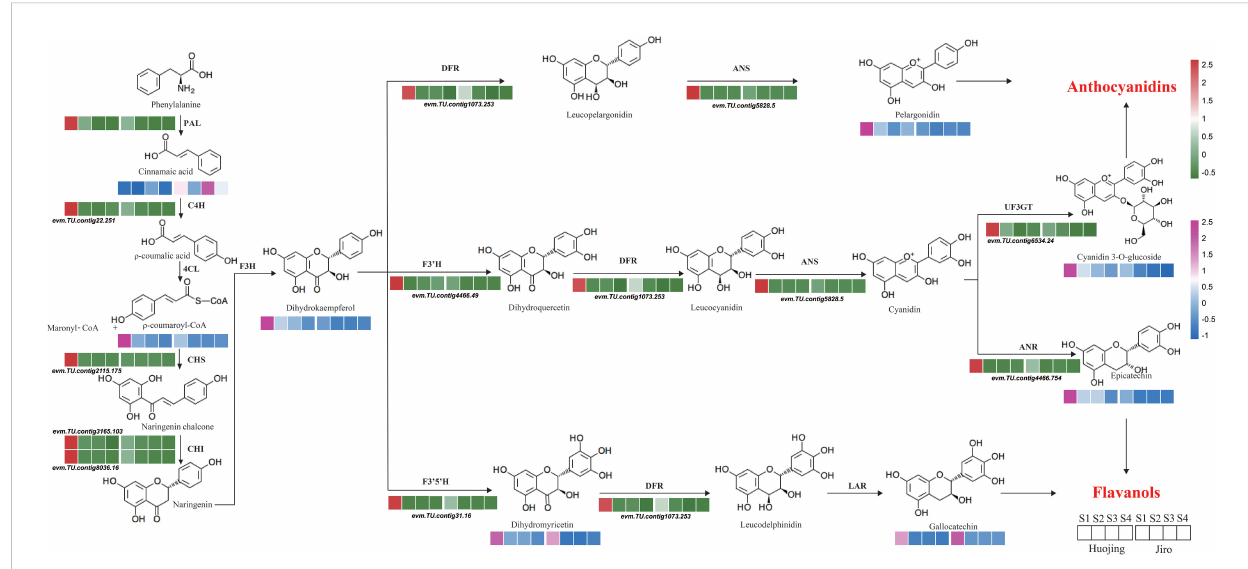
FIGURE 6 Diagram of phenylpropanoid and fl avonoid biosynthetic pathways involving DEGs and DEMs. Heatmaps represent the normalized expression